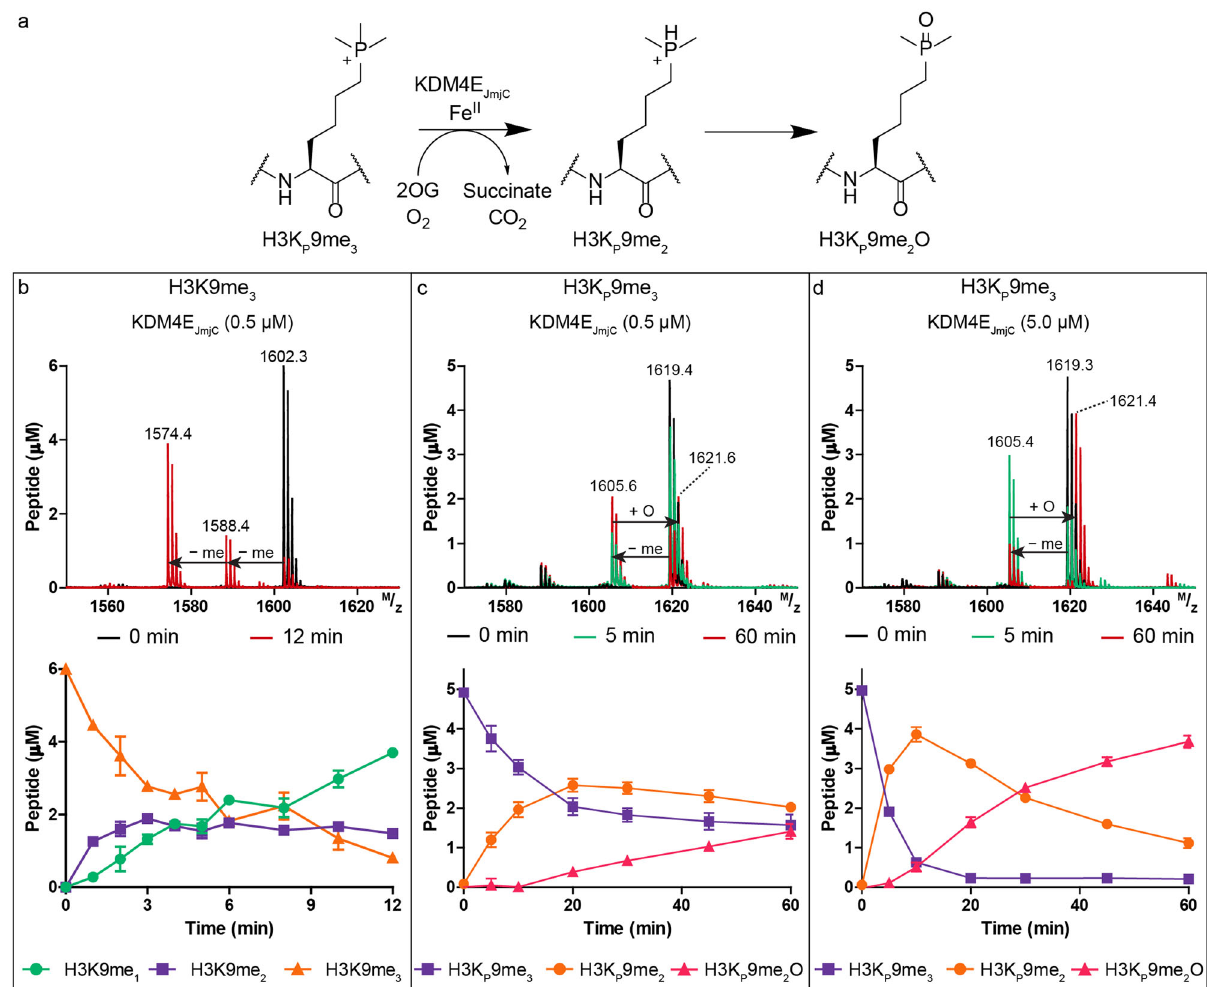
Fig. 5 KDM4E JmjC catalyses demethylation of H3K P 9me 3 to give H3K P 9me 2 . a KDM4E JmjC catalysed demethylation of H3K P 9me 3 . b Mass spectra and time-course analysis of H3K9me 3 (6.0 µ M) and KDM4E JmjC at 0 min (black) and 12 min (red) showing the substrate H3K9me 3 (orange) and demethylated products H3K9me 2 (purple) and H3K9me 1 (green). Mass spectra and time-course analysis of H3K P 9me 3 (5.0 µ M) and KDM4E JmjC ( c 0.5 µ M, d 5.0 µ M) at time points 0 (red), 5 (green) and 60 min (red) acquired using MALDI-TOF MS. Conditions: Asc (500 µ M), Fe(II) (50 µ M) and 2OG (100 µ M). Errors represent standard deviations ( n = 2 or ( + 16 Da), was observed (Fig. 5c, d). Reaction of stoichiometric amounts of KDM4E JmjC (5.0 µM) and H3K P 9me 3 (5.0 µM) showed faster H3K